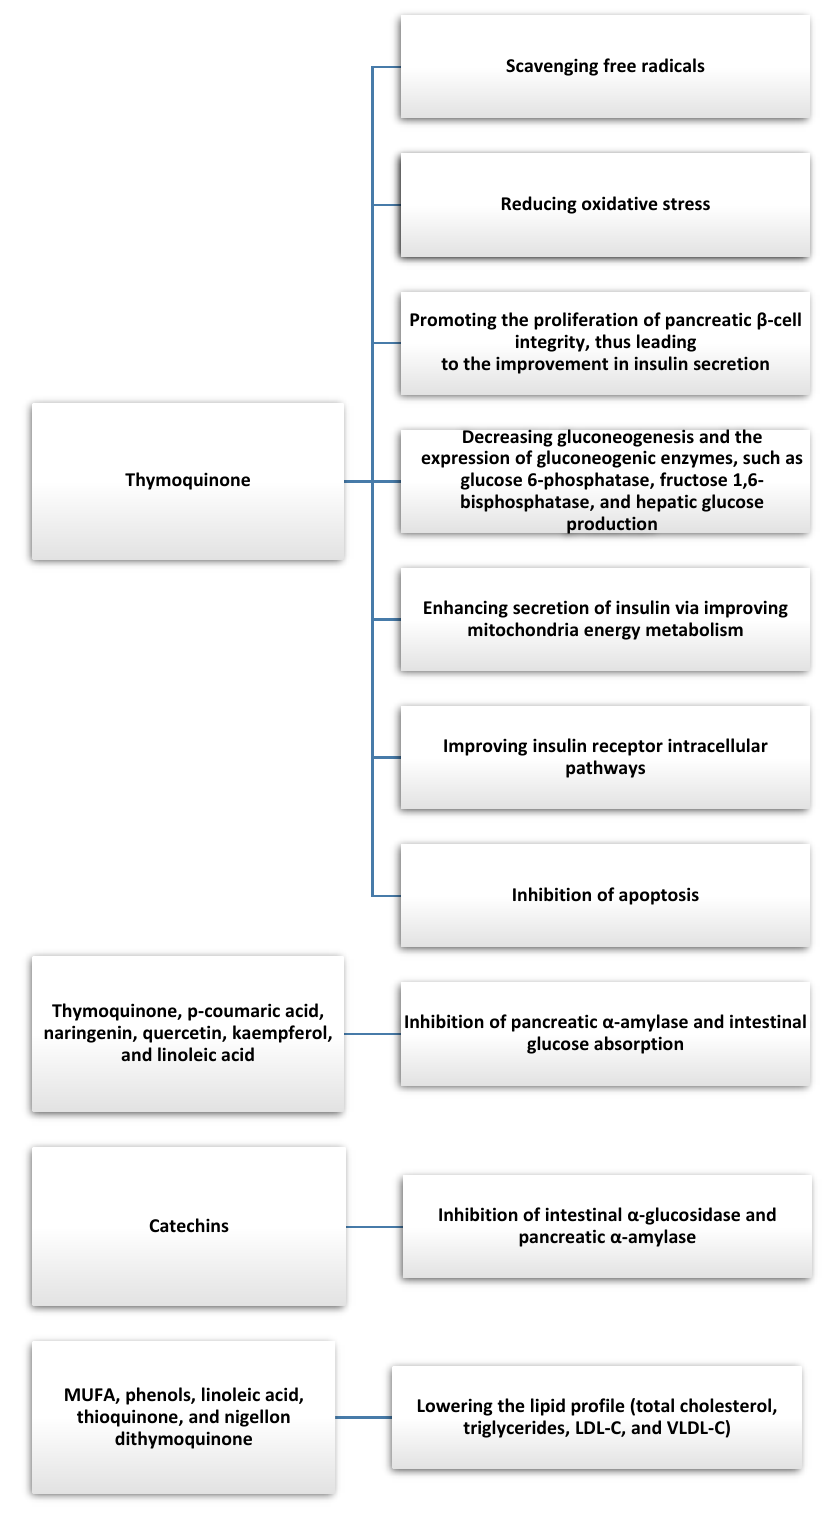
Figure 2. Antidiabetic and antihyperlipidemic effects of bioactive compounds and fatty acids found in Nigella Sativa [26,27,33 – 35,41].